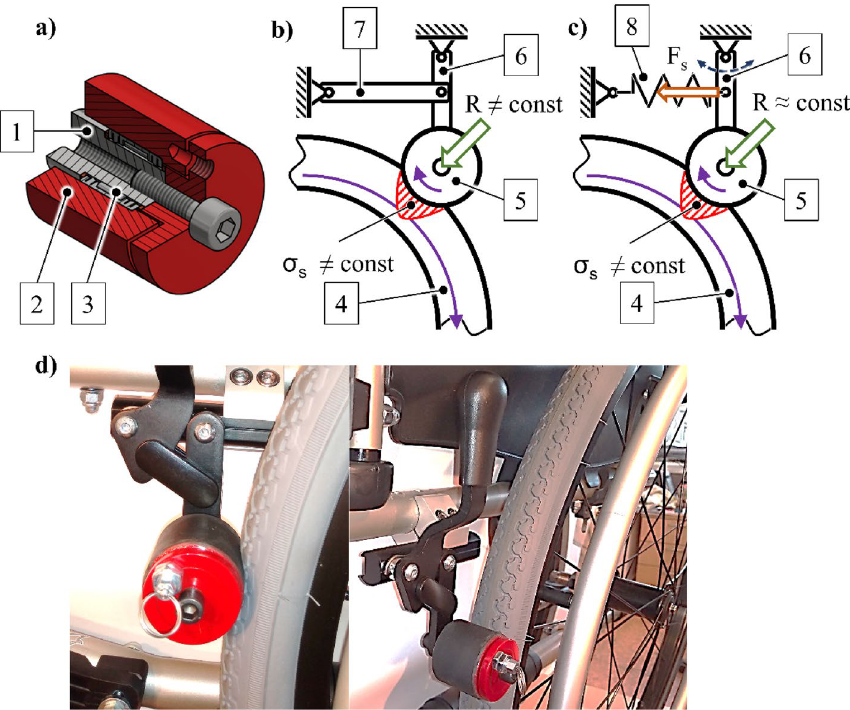
Figure 2. Anti-rollback system ( a ) coupling with the drive wheel by means of a rigid body ( b ) and elastic body ( c ), implementation of a rigid body variant ( d ); where: 1—central axle, 2—anti-rollback roller, 3—one-way clutch, 4—pneumatic drive wheel, 5—anti-rollback system, 6—articulated link, 7—rigid beam, 8—tension